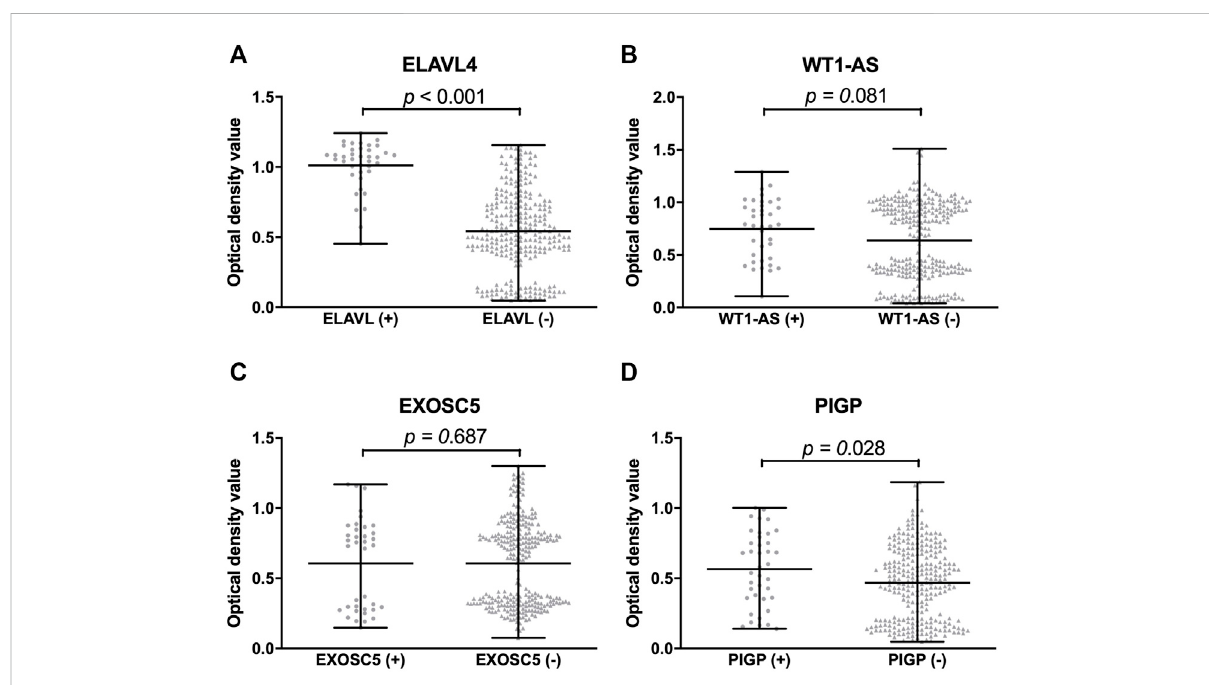
FIGURE 6 Comparison of optical density value of validated proteins between protein positive group and negative group by IBS focused microarray. The optical density value of ELAVL4 (IgG) of protein positive group is signi fi cantly higher than negative group by IBS focused microarray (A) . The optical density values of WT1-AS and EXOSC5 (IgG) are not signi fi cantly different between protein positive group and negative group (B,C) . The optical density value of PIGP (IgA) of protein positive group is signi fi cantly higher than negative group by IBS focused microarray (D)